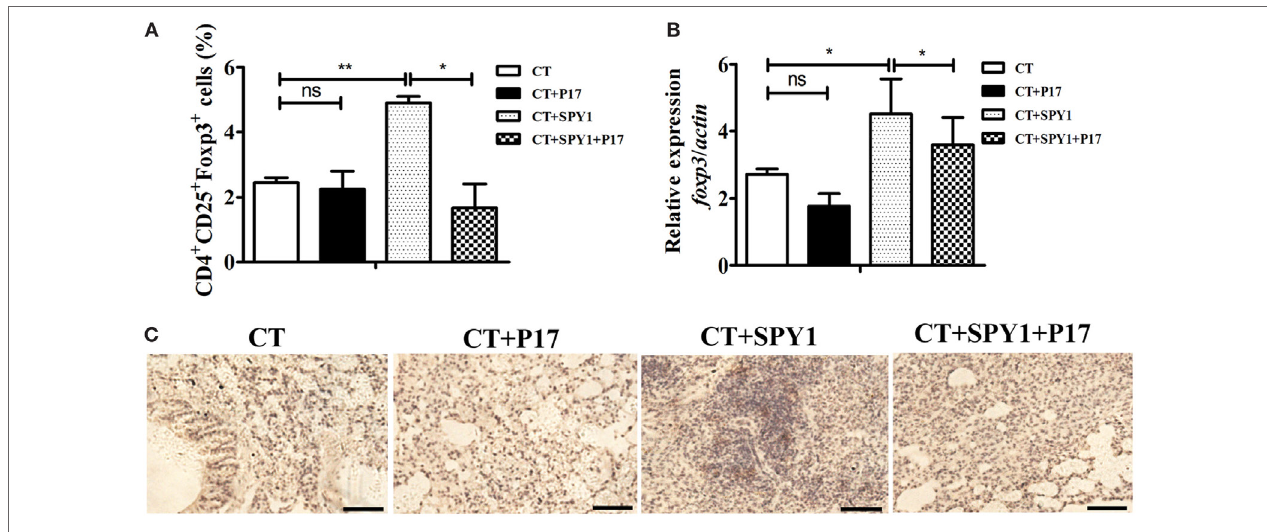
FigUre 4 | SPY1 vaccination activates the expression of regulatory T cells (Tregs) molecule Foxp3. (a) On day 7 after the last immunization, mice lungs were aseptically removed and homogenized, and single lung cell was stained with anti-mouse CD4-FITC and anti-mouse CD25-APC, followed by anti-mouse Foxp3-APC according to the manufacturer’s instructions. Cells were analyzed using a Becton Dickinson FACSCalibur flow cytometer then. The percentages of CD4 + T cells which were CD25 + Foxp3 + Treg were calculated. (B) On day 7 after the last immunization, mice lungs were aseptically removed, and total RNA were extracted. Expression of foxp3 mRNA was analyzed by quantitative real-time PCR. Data were shown as mean ± SD from three independent experiments. (c) On day 7 after the last immunization, mice lungs were aseptically removed, and lung sections were stained with anti-FOXP3 antibody followed by streptavidin horseradish peroxidase chemistry. Then, the sections were examined under light microscopy at 100 × magnification. Scale bar = 100 µm. Images were representative of staining observed in the lungs of mice within the group ( n = 4–6 mice). * p < 0.05; ** p <